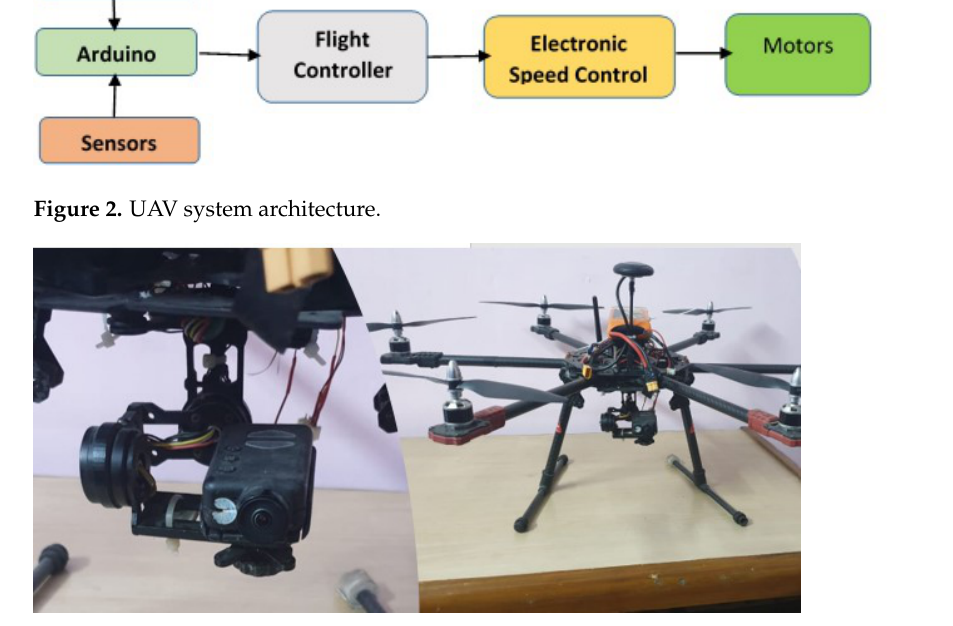
Figure 3. The designed camera and UAV. Table 1. Specifications of the designed